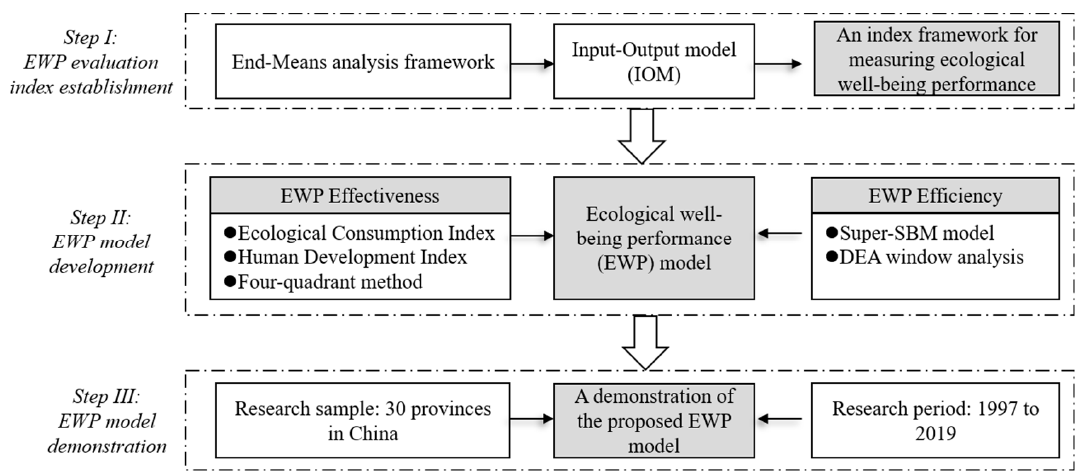
Figure 1. Research procedures designed in this study.